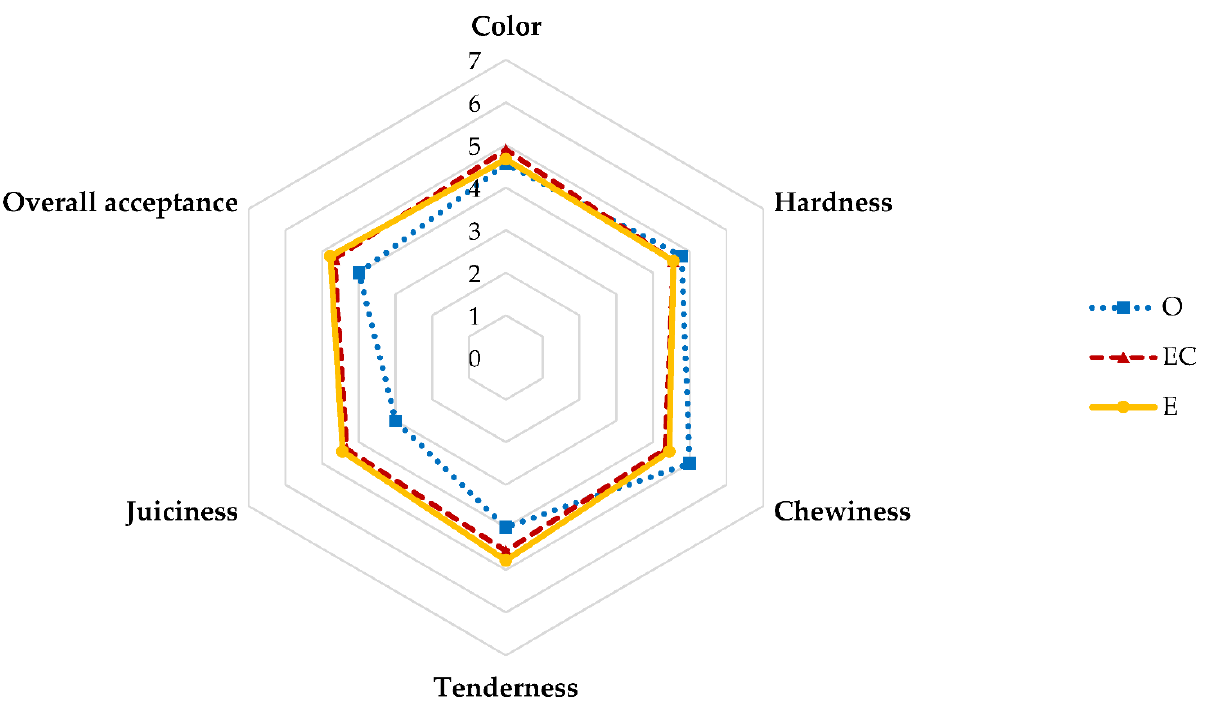
Figure 4. Sensory evaluation of meat analogs with different fat replacers (O, EC, and E) during the freezing storage ( − 18 °C) for six months. O: oil, EC: non-emulsified emulsion control; and E: emulsion.